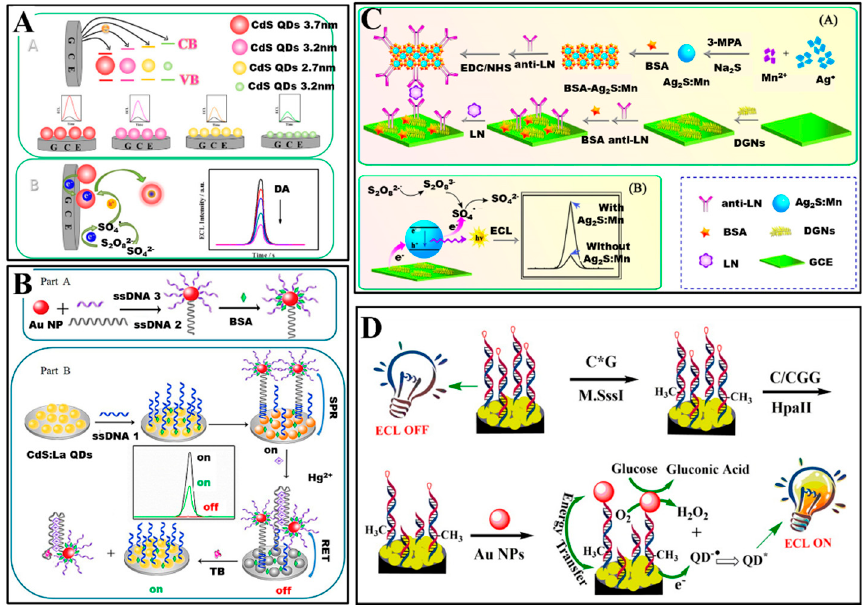
Figure 4. ( A ) ECL biosensors for dopamine based on CdS QDs [134]. Reproduced with permission